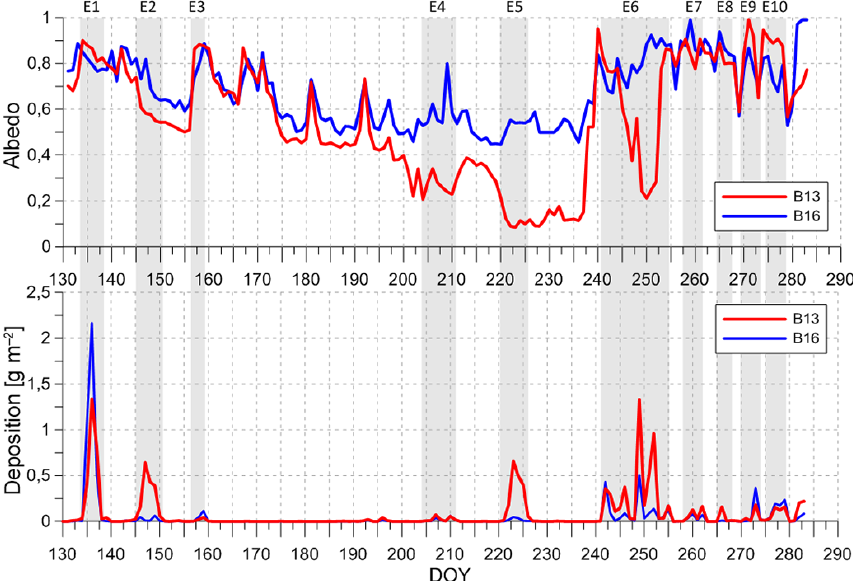
Figure 3. Upper graph: albedo measurement from the AWS at B13 in red and B16 in blue for the measurement period in 2012. Lower graph: daily dust deposition showing dust events modelled by FLEXPART. Dust events are highlighted in grey and named E1–E10. Table 3. Same as Table 2 but for station B16. Model AWS Event Duration Concentration Deposition Albedo Temperature Precipitation